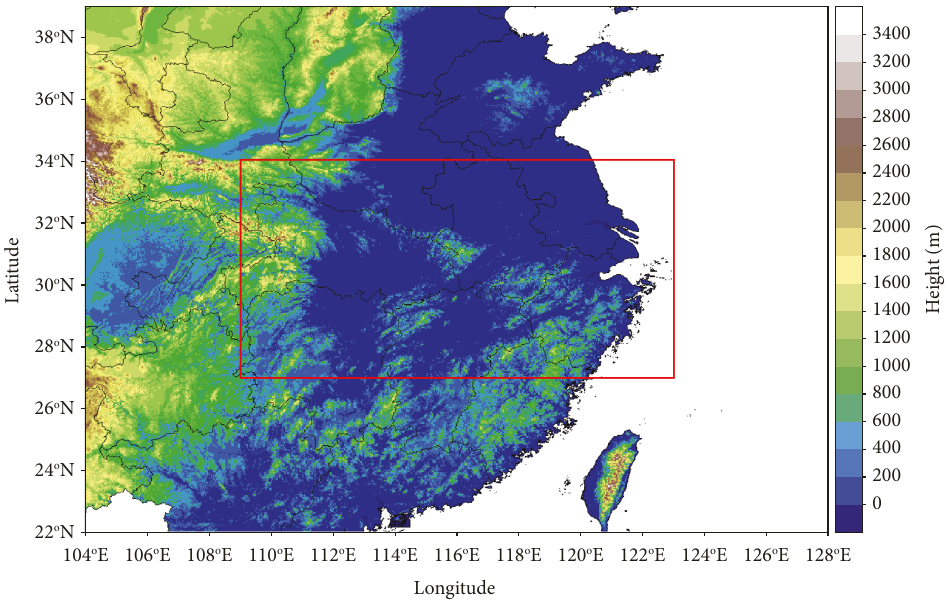
Figure 1: Study location and topography (shaded, unit: m) in the MLYRB (red rectangle